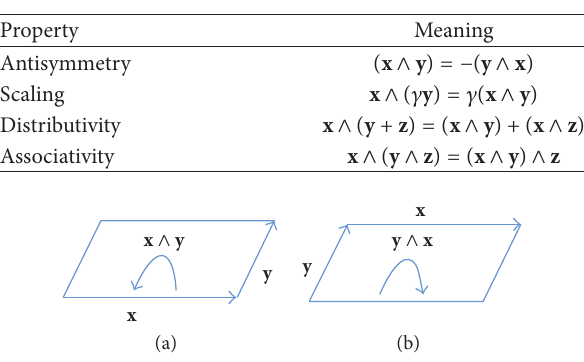
Table 1: Properties of the outer product.